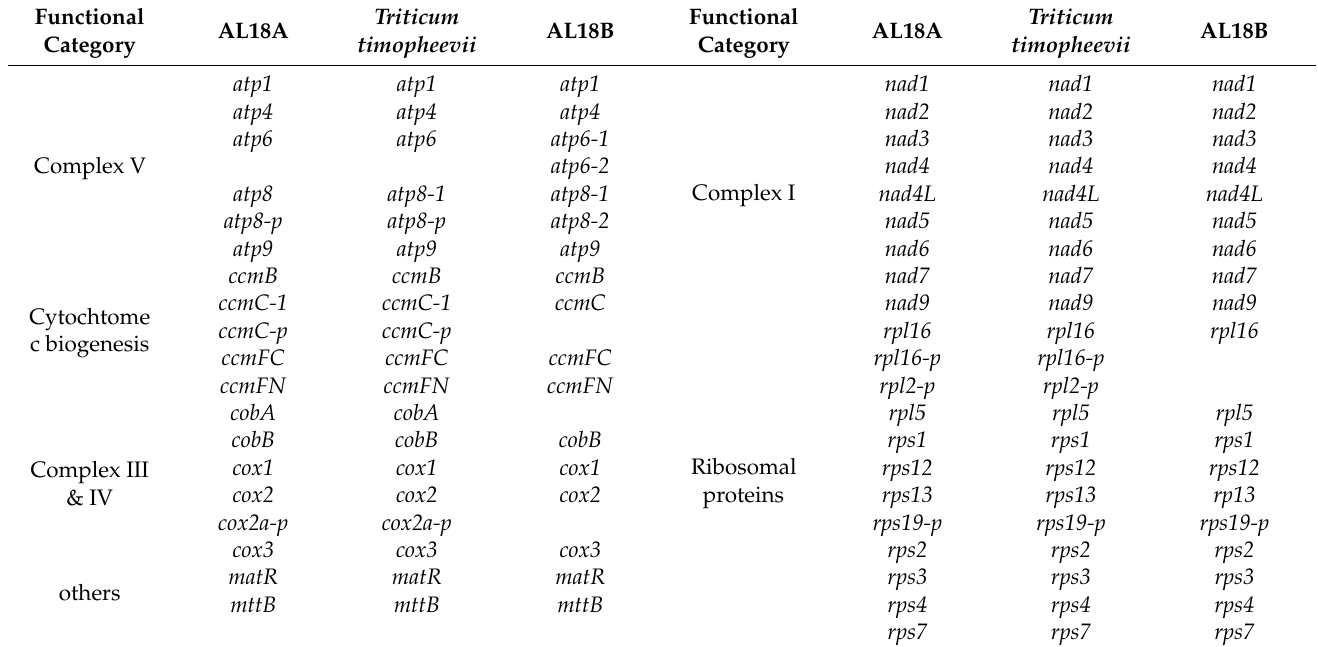
Table 3. Comparison of coding genes in different mitochondrial genomes.